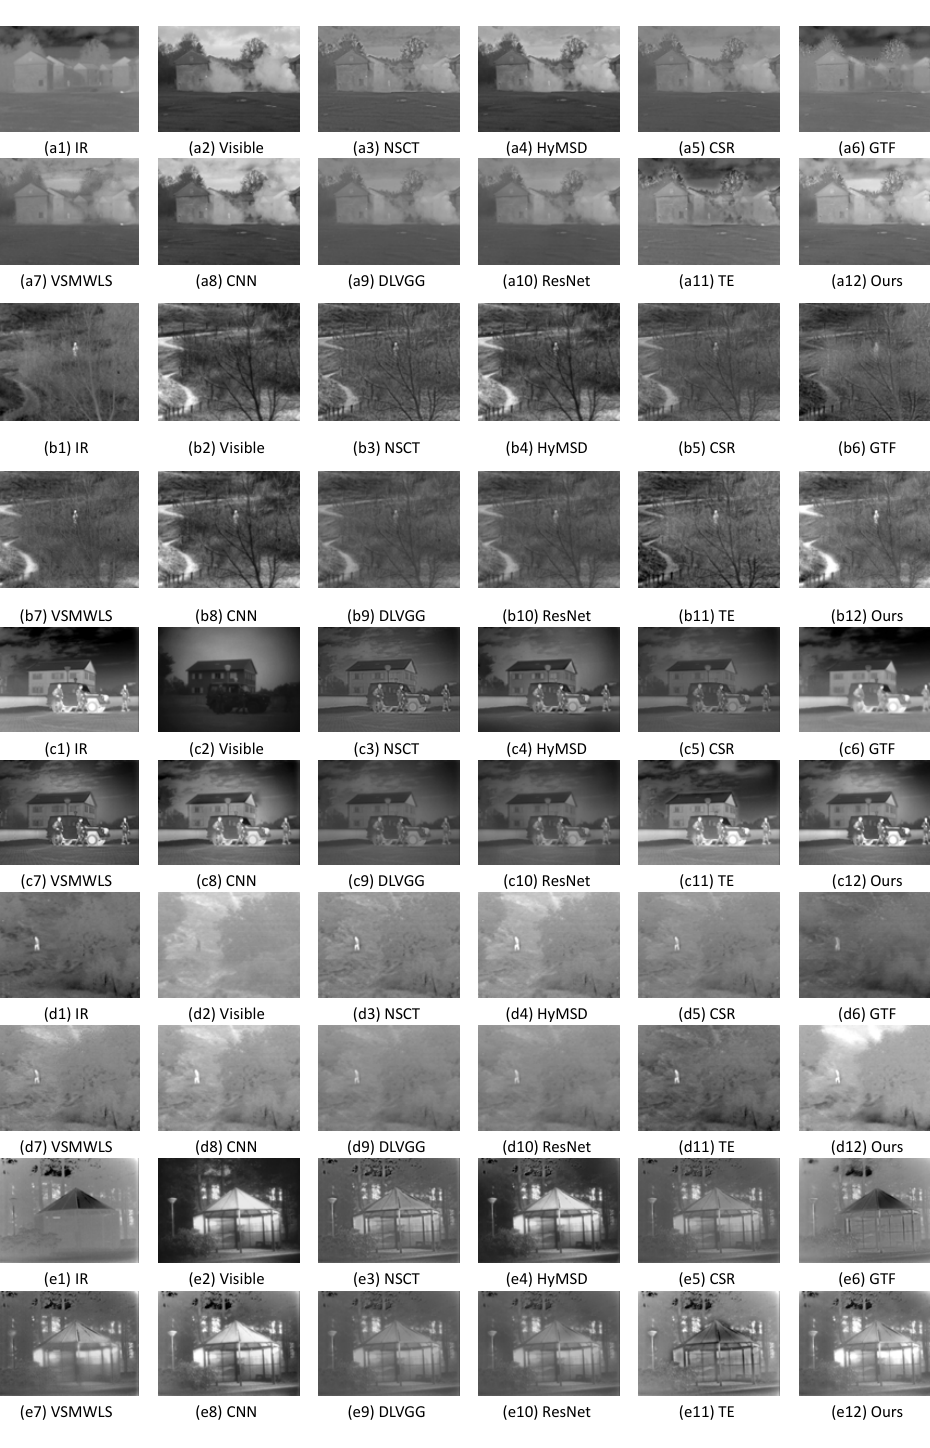
Figure A1. Fusion performances of various methods on the IR and visible image pairs. From top to bottom: ‘Octec’, ‘Sandpath’, ‘Soldiers with jeep’, ‘Trees4906’, and ‘Kaptein19’